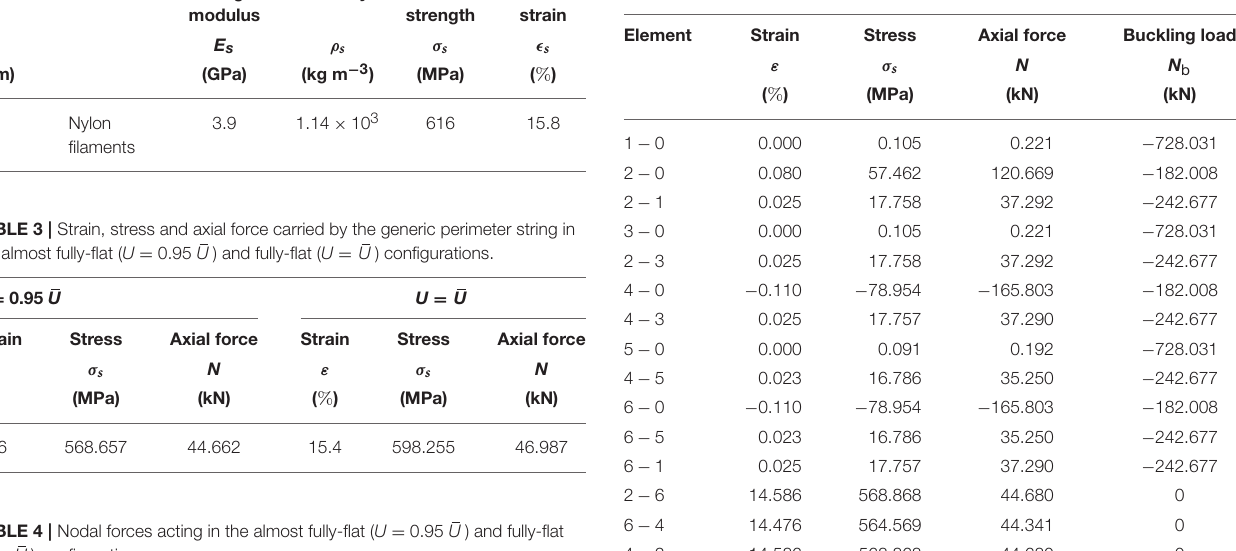
0.95 U ) and fully-flat =